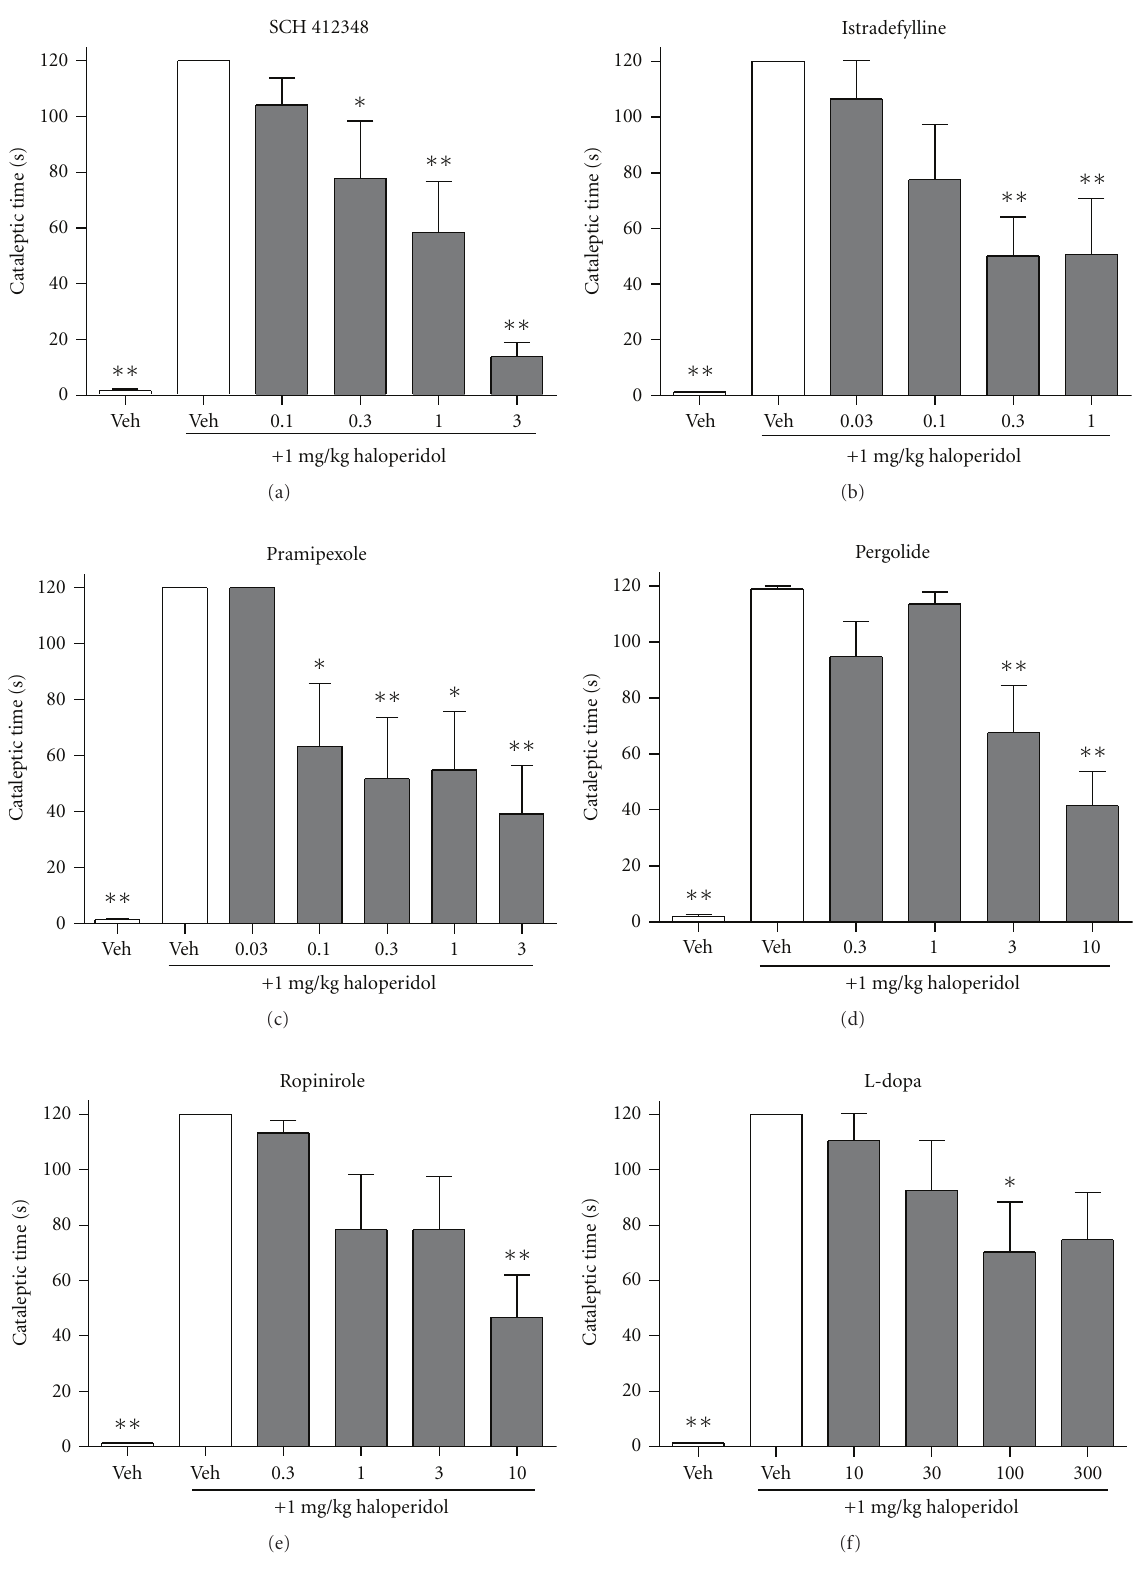
Figure 1: E ffi cacy of SCH 412348 (a), istradefylline (b), pramipexole (c), pergolide (d), ropinirole (e), and L-dopa (f) to reduce catalepsy induced with 1mg/kg haloperidol in rats. Data represent mean time cataleptic ± SEM and were analyzed by one-way ANOVAs with Dunnett’s tests ( ∗ P < 0 . 05; ∗∗ P < 0 . 01 versus vehicle + haloperidol